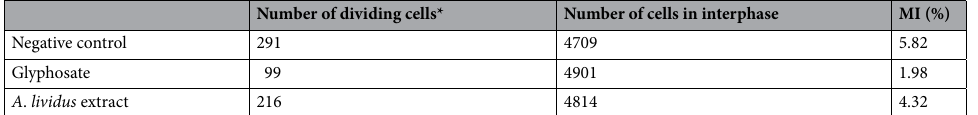
Table 3. Anti-proliferative activity of A. lividus extract. *Indicates the number of cells in prophase, metaphase, anaphase and telophase.